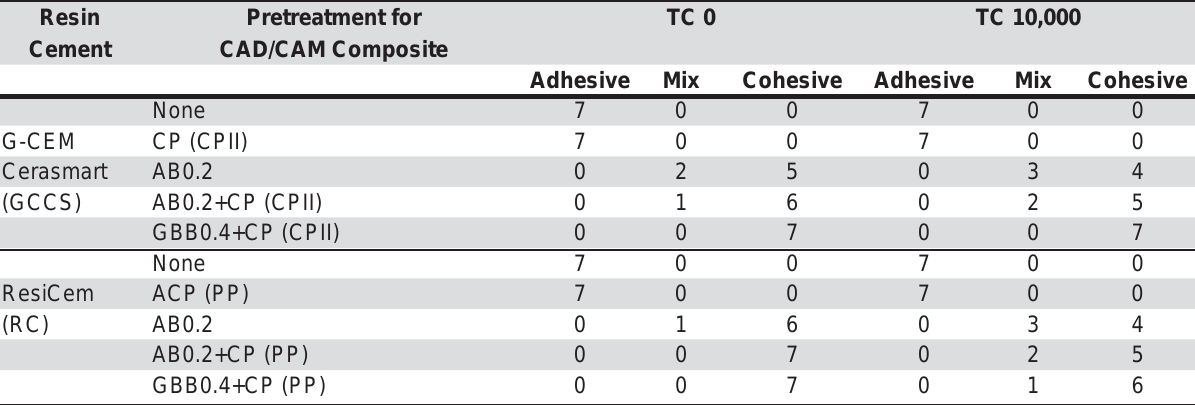
Table 3- Bonding fracture modes observed for different combinations of resin cement and Resin Cement